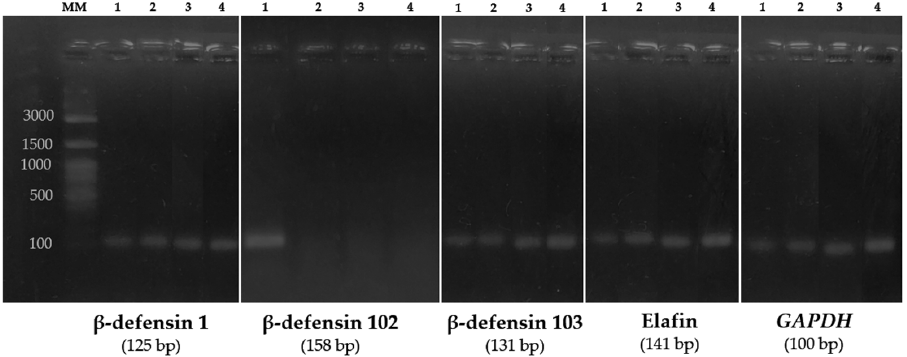
Figure 1. Expression of canine β -defensin and Elafin in canine AM. RT-qPCR products amplified from the cDNA of each dog were fractionated on 2% agarose gels and stained with Novel Juice dye. Numbers represent each canine amniotic membrane sample in each column. MM was molecular size marker (100 bp). GAPDH was used as positive internal control (reference gene). RNase-free water was used as negative control. Numbers on the left indicate sizes (bp) of the molecular weight